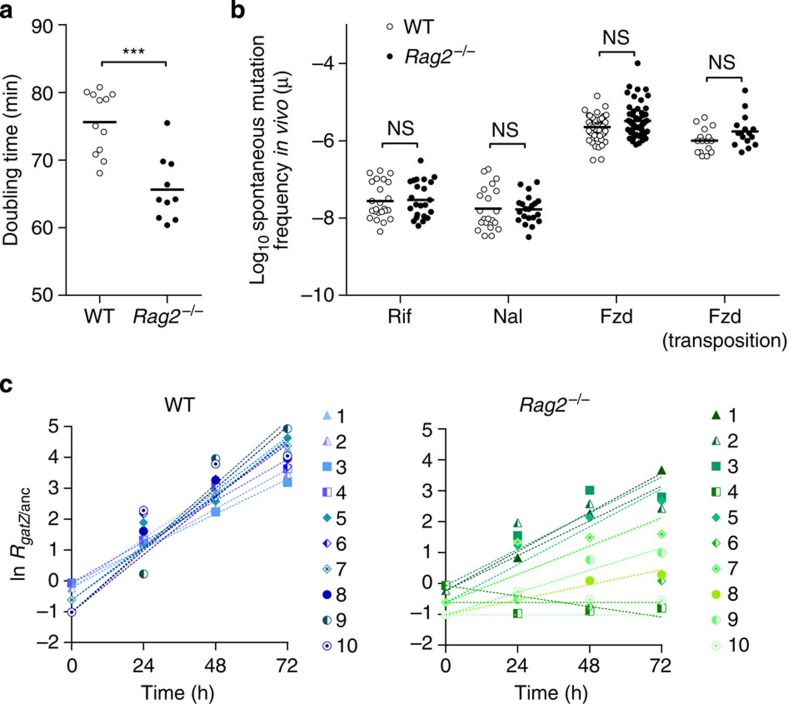
Selection strength, not mutation rate, is responsible for a lower rate of adaptation in immune-compromised mice.(a) Higher growth rate of E. coli in immune-compromised mice. The doubling time of E. coli colonizing the gut of WT or Rag2−/− is estimated by the amount of rRNA (see Supplementary Fig. 3). Each symbol corresponds to an average of two independent quantifications made for each mouse (n=6) during days 1 and 3 of colonization. The doubling time is significantly lower in Rag2−/− than in WT mice, indicating that E. coli divides faster in the gut of Rag2−/− than in WT animals (Mann–Whitney U-test, W=111.5, P<10-3). ***P<0.001. (b) Similar frequency of spontaneous mutation in immune-competent and immune-compromised mice: the log10 frequency of spontaneous resistance (μ) in WT (open circles) and in Rag2−/− (full circles) animals is proportional to the mutation rate at mutation-selection balance. Symbols correspond to measurements of mutation frequency over a period of 15 days for rifampicin (n=6), nalidixic acid (n=6) and furazolidone resistance (n=11 and 10). We estimated an average log10
μWT∼−7.56 and μRag2−/−∼−7.53 for rifampicin (Mann–Whitney U-test, W=284.5, P=0.95), μWT∼−7.76 and μRag2−/−∼−7.77 for nalidixic acid (Mann–Whitney U-test, W=202, P=0.65) and μWT∼−5.65 and μRag2−/−∼−5.49 for furazolidone resistances (Mann–Whitney U-test, W=1613, P=0.10). The frequency of spontaneous transpositions corresponds to the fraction of mutations conferring furazolidone resistance, which are caused by insertion of transposable elements: μTE WT∼−5.99 and μTE Rag2−/−∼−5.75 (Mann–Whitney U-test, W=83, P=0.09). NS, not significant; P>0.05. (c) Mean selective advantage of an emerging gat allele is lower in Rag2−/− than in WT mice. Results of short-term competitive fitness experiments (n=10) between a gatZ mutant and the ancestral E. coli. Rag2−/− (right panel) or WT (left panel) mice from the same litter are represented by symbols of the same shape (triangles, squares, diamonds or circles). The selective advantage of gatZ along the 3 days of competition is inferred from the slope of the linear regression of ln(gatZ/anc), (dashed lines, shown for each mouse), which corresponds to the selection coefficient.